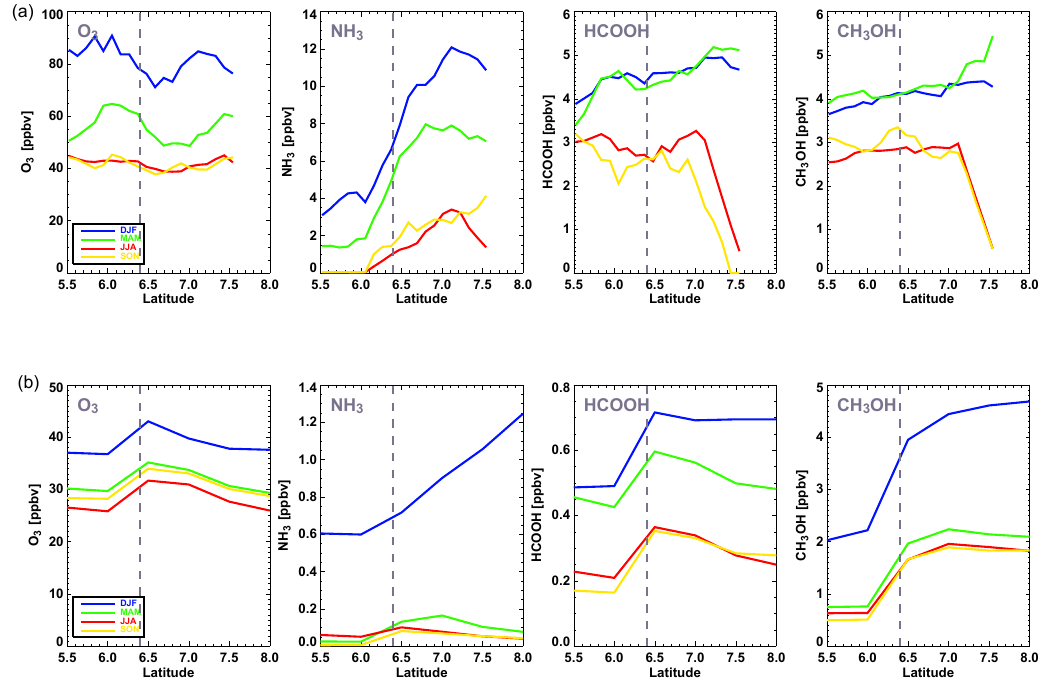
Figure 12. Seasonal means along the Lagos transect. TES 2013–2015 means (a) , GEOS-Chem 2012 means (b) . Note different y -axis vertical range between TES and GEOS-Chem plots. Dashed line indicates latitude of land–sea